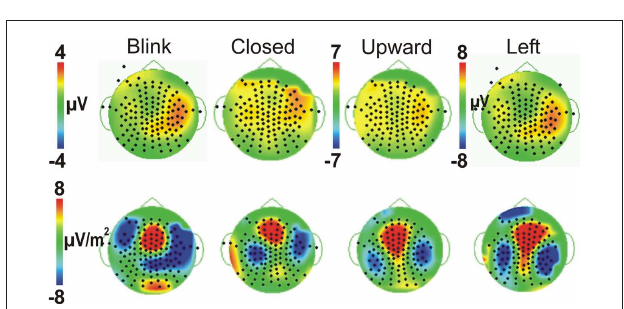
charts (at right). Gray stars in (B) indicate the peak electrodes (anterior temporal) for the Blink condition P450. Amplitude charts show all four conditions (A) P250, (B) P450, and (C) P600. Significant differences on the charts are not indicated due to complexity, but are listed in